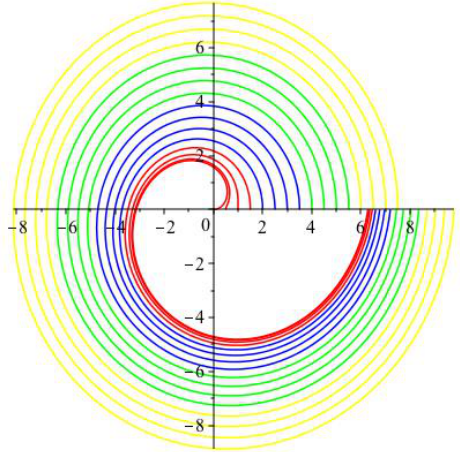
Figure 1. Plot of contours obtained by using Maple 2019 software; red corresponds to the values z = 0, 0.5, 1, 1.5, blue to the values z = 2, 2.5, 3, 3.5, green to the values z = 4, 4.5, 5, 5.5 and yellow to the values